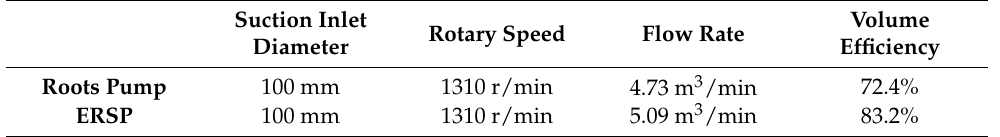
Table 2. Experimental results of roots pump and the